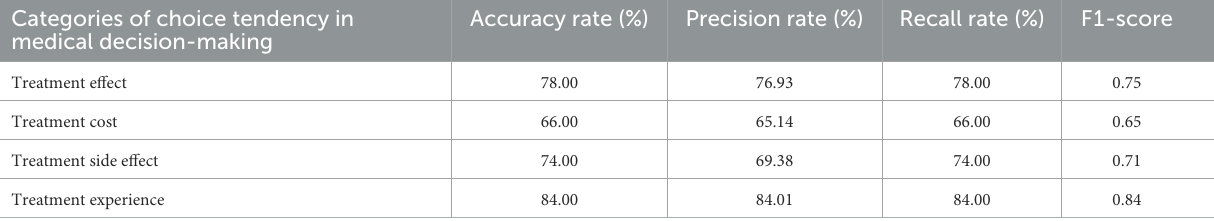
TABLE 4 Model evaluation effect of k-nearest neighbors algorithm. Categories of choice tendency in medical